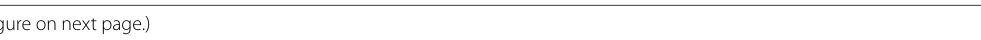
figure on next Fig. 1 CD44 regulates cardiac remodeling and cardiac function in the early stage of MI. A CD44 is highly expressed in the heart in the early stage of MI. Representative confocal microscopy images of CD44 (red) expressed in cardiac border zone (c, f) and infarct zone (d, e) in 1-week MI mouse hearts and normal hearts (a, b). DAPI (blue) stained nuclei and cTnT (green) labeled cardiomyocytes. Scale bars: 400 μm (upper panel); 100 μm (lower panel). B The statistical data of CD44 relative fluorescence intensity in normal hearts (Sham), infarct zone (MI-I), border zone (MI-B), and remote area (MI-B) in MI mouse hearts. n 3. C Schematic illustration of the mouse MI experiment. D The echocardiography results of the = WTSham, KOSham, WTMI, and KOMI groups 1 week post-MI. LVIDd, left ventricular internal dimension at end-diastole; LVIDs, left ventricular internal dimension at end-systole. E The statistical data of left ventricular ejection fraction (LVEF), left ventricular fractional shortening (LVFS), left ventricular end-diastolic volume (LVEDV), and left ventricular end-systolic volume (LVESV) of WTSham (n 10), KOSham (n 11), WTMI (n 24), and KOMI = = = (n 19) groups. * P < 0.05, ** P < 0.01, *** P < 0.001, ns no significance. Echo, =